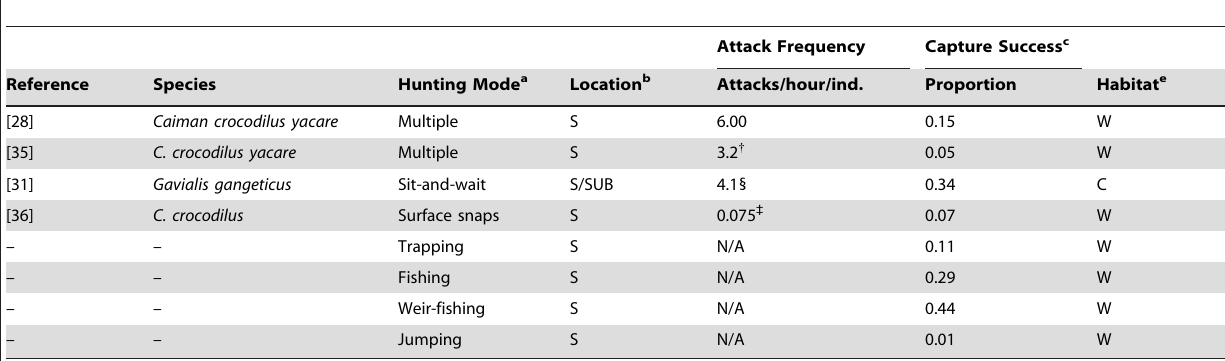
Table 1. Published results regarding the feeding behaviors of